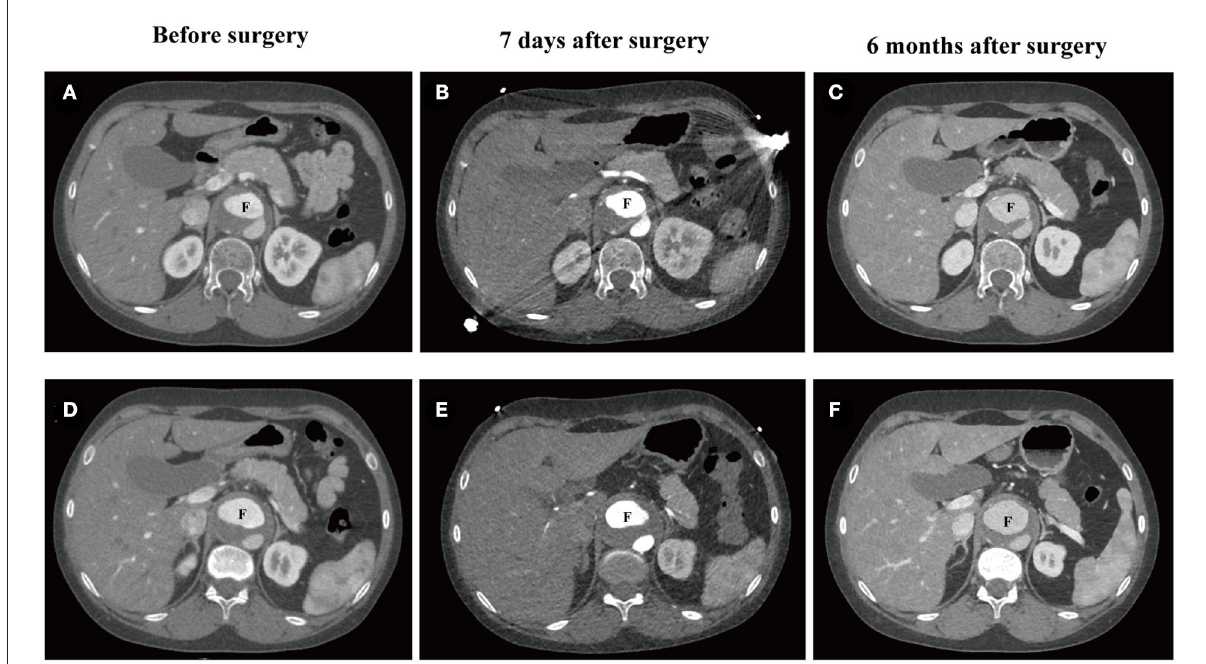
FIGURE3 CTA of abdominal aortic dissection in the 25-year-old female patient. (A–C) The false lumen at the position of intimal tears before surgery (32.8 × 22.8 mm 2 ), 7 days after surgery (32.6 × 22.2 mm 2 ), and 6 months after surgery (35.9 × 26.8 mm 2 ). (D–F) Maximum diameter of the false lumen of AAD before surgery (38.9 × 23.1 mm 2 ), 7 days after surgery (39.3 × 24.6mm 2 ), and 6 months after surgery (40.9 × 29.1 mm 2 ). CTA, computed tomography angiography; F, false